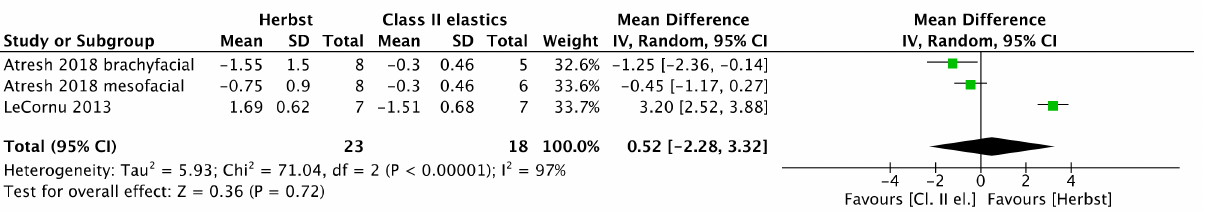
Figure 21. Forest plot of the left Co point anteroposterior changes using the random effects model [43,44].